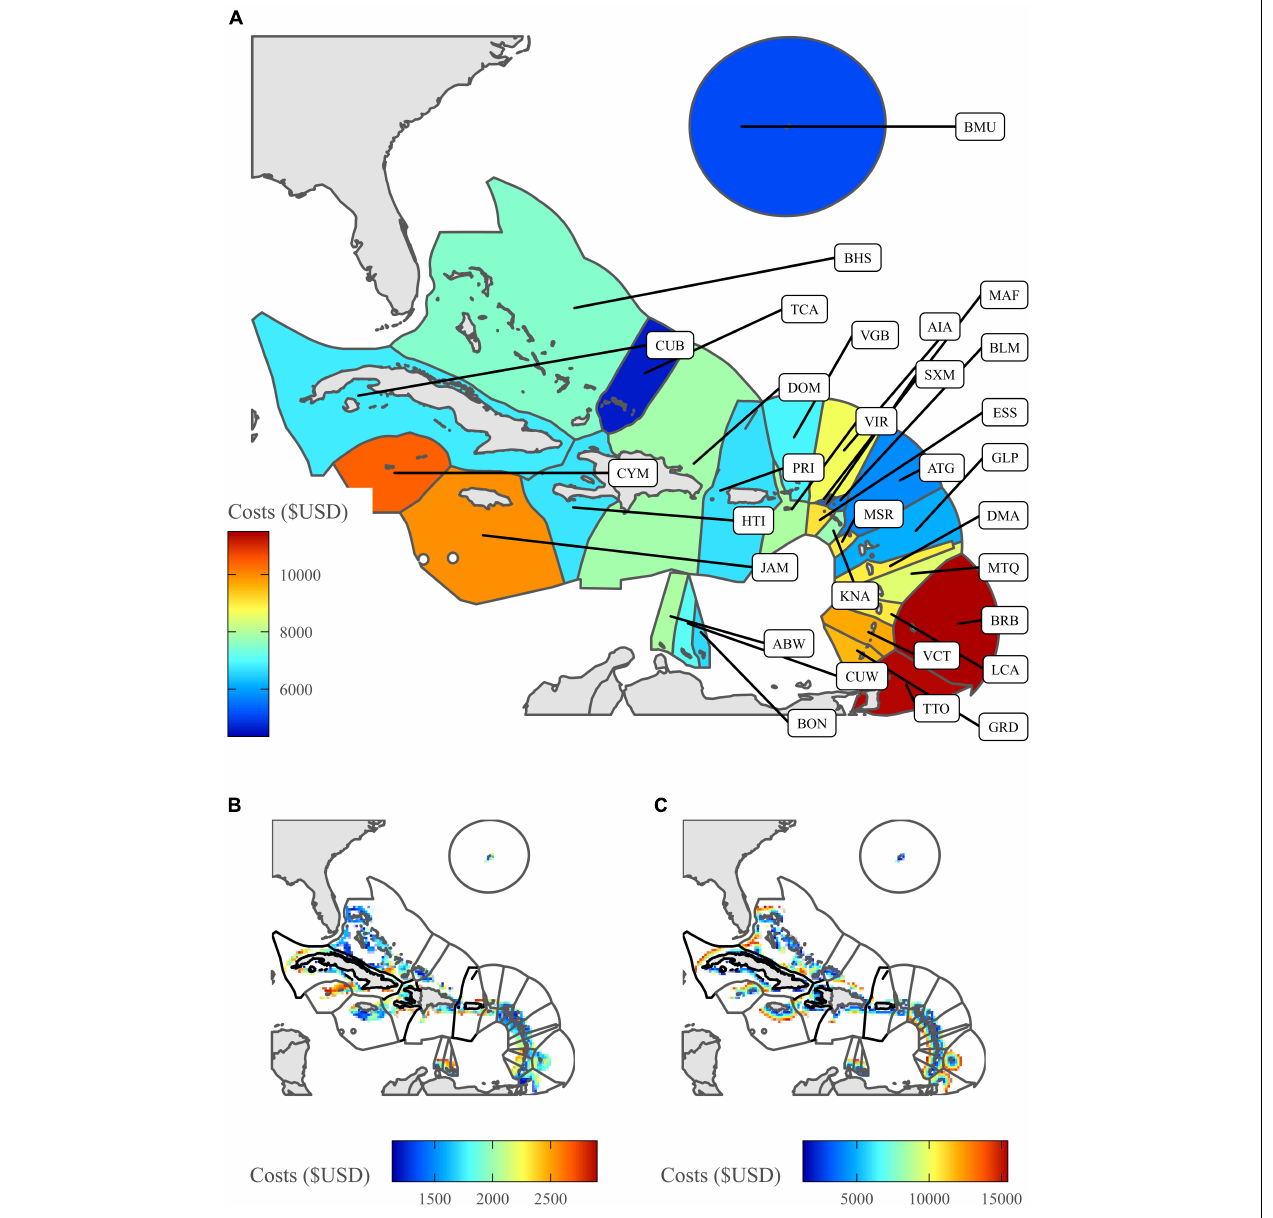
FIGURE 2 | Estimated cost of Moored Fish Aggregating Device (MFAD) deployment and utilization based on site depth and current and using a standardized MFAD design. Suitable sites are restricted to those within 50 nautical miles of shore, between 100 and 3,000 m depth, with less than 0.65 m/s surface current, and outside of formal shipping lanes. Shape outlines represent EEZs. (A) Mean costs across EEZ, (B) costs of MFAD deployment in suitable sites, (C) costs of MFAD utilization in suitable